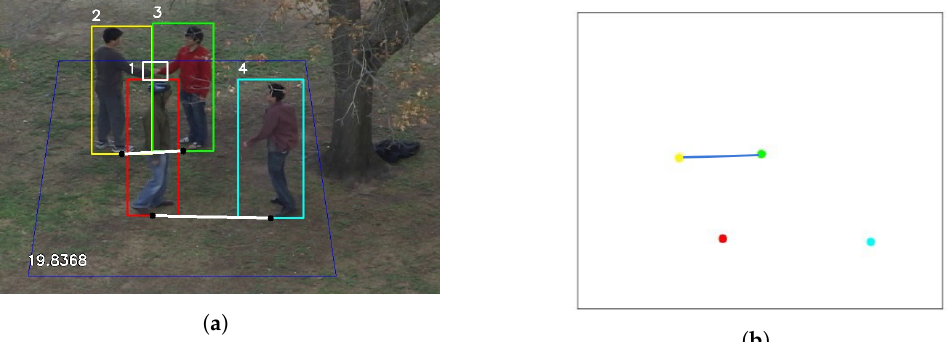
Figure 4. Graph representation figure. ( a ) Bounding boxes for people and handshake; ( b ) Corre- sponding graph